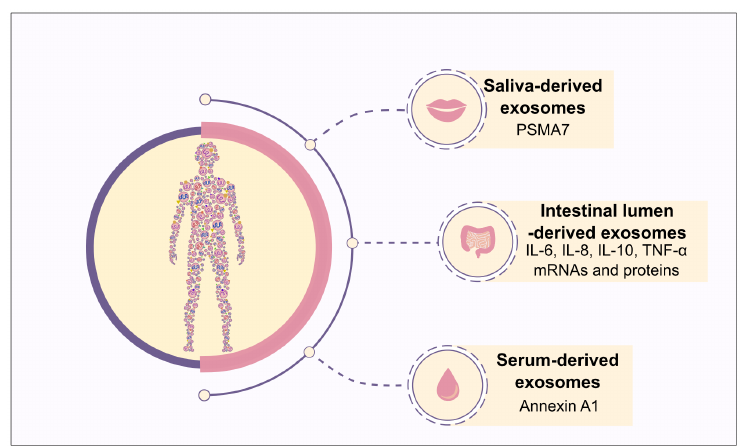
Figure 2. Diagnostic potential of exosomes in IBD. Exosomes derived from saliva, intestinal lumen as well as serum, which contain PSMA7, pro-inflammatory cytokine mRNAs and proteins, and annexin A1, respectively, could be used as promising biomarkers for IBD diagnosis.